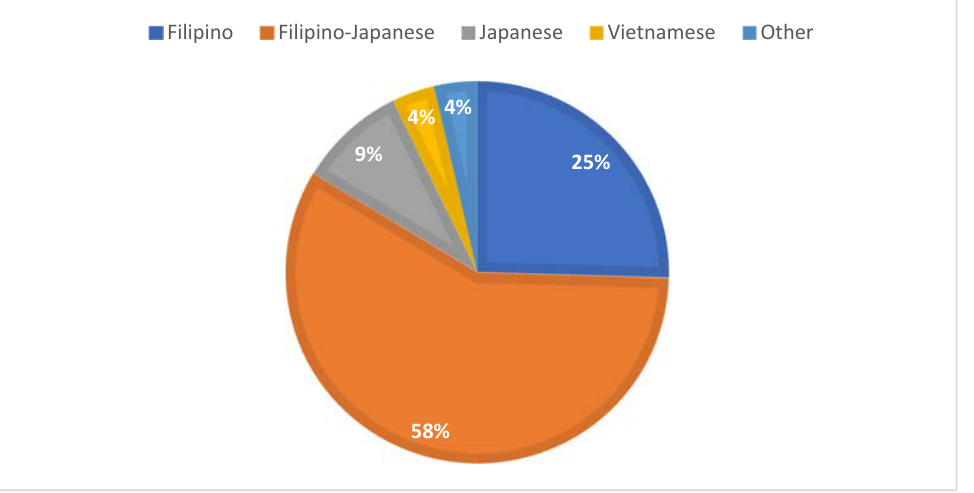
Figure 1. Church school catechism class ethnic composition April 2017–June 2018 (n = 55).